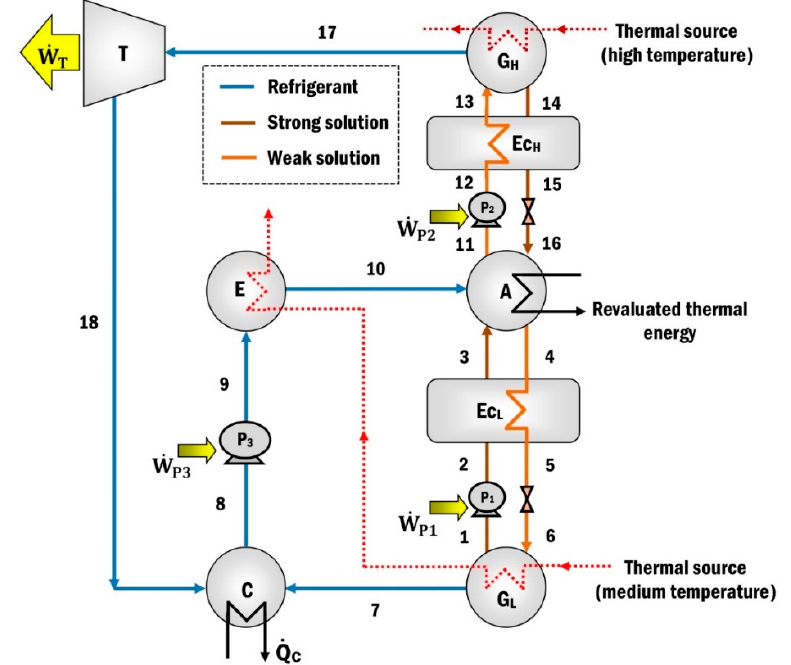
Figure 1. The modified absorption heat pump (MAHP).